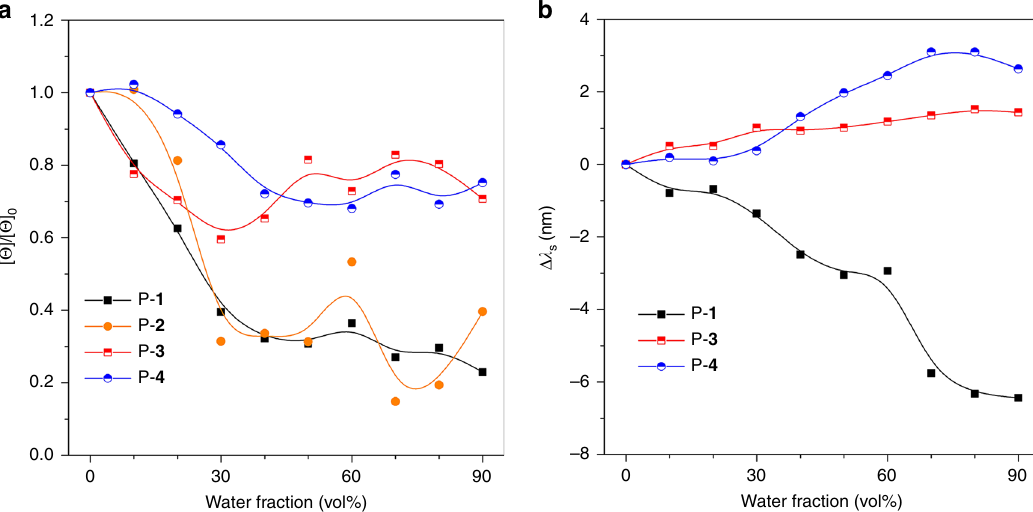
Fig. 4 Experimental analysis of chiroptical properties within the process of aggregation. a Plots of [ Θ ]/[ Θ ] 0 versus the composite of P- 1 to P- 4 in THF/water mixtures at a concentration 10 − 4 M. [ Θ ] 0 = molar ellipticity at water fraction ( f w ) = 0%. The values of [ Θ ] were acquired from the peaks at 280, 240, 280, and 250nm for P- 1 , P- 2 , P- 3 , and P- 4 , respectively. b Plots of Δ λ s versus f w , where Δ λ s = Δ λ max – Δ λ max-0 and Δ λ max-0 = wavelength splitting at f w =